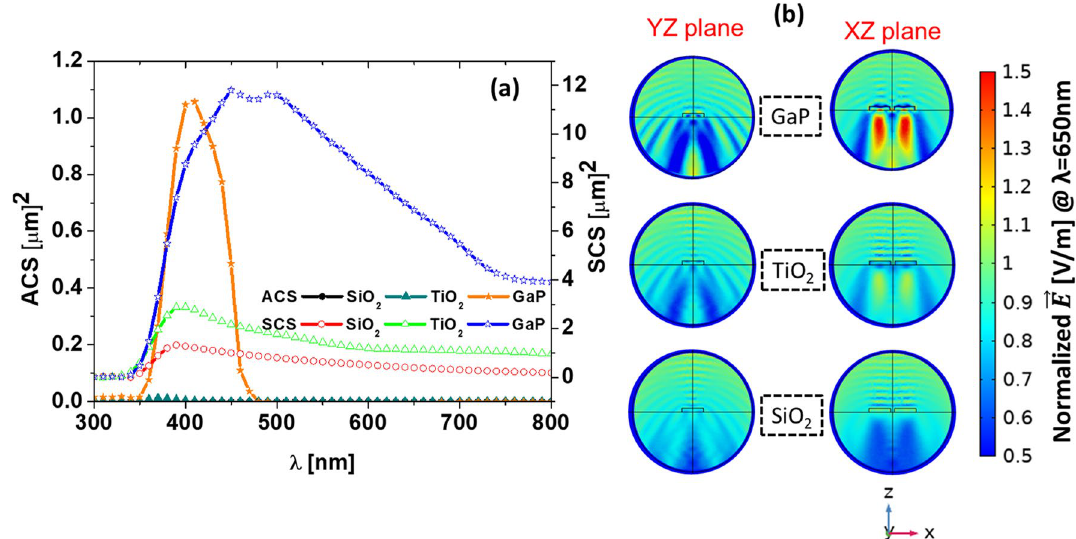
Figure 7. ( a ) Scattering cross section of the optimum nano-dimer (see the geometrical parameters in table 2) dimer nanoaprticle (dimer element width GW=575nm, and gap 50 nm) made from SiO 2 (red solid line with open circles), TiO 2 (green solid line with open up triangles), and GaP ( blue solid line with open stars). The corresponding absorption cross section are shown as SiO 2 (black solid line with closed circles), TiO 2 (dark green solid line with closed up triangles), and GaP ( orange solid line with closed stars). ( b ) Spatial distribution of the normalized scattered electric field of the dimer for the three materials (GaP, TiO 2 , and SiO 2 ), for the two orthogonal planes of interest ( XZ and YZ ) at (cid:31) = 650